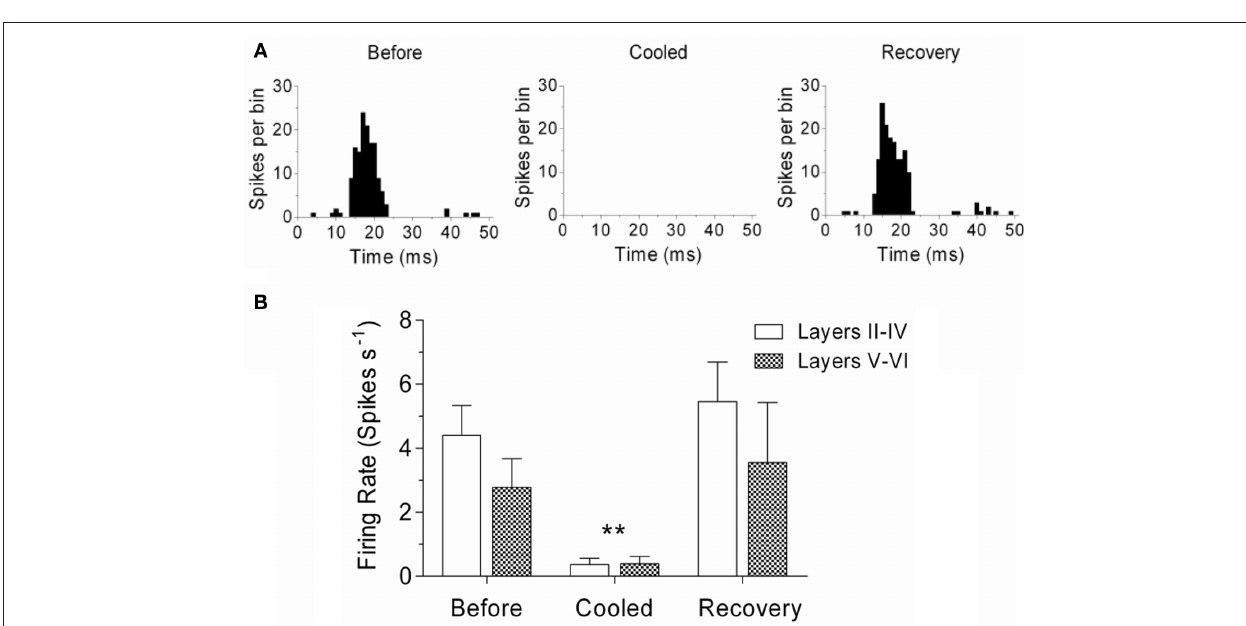
Figure 4 | Single-unit activity in auditory cortex. (A) Representative examples of single-unit activity from layer V/VI of auditory cortex before cooling, during cooling (surface 2 ° C), and after recovery. (B) Changes in firing rate before, during and after cooling; single-units divided into two groups: Layers II–IV and Layers V–VI. Firing rate ( ± SEM) was significantly lower during cooling in both groups ( P <